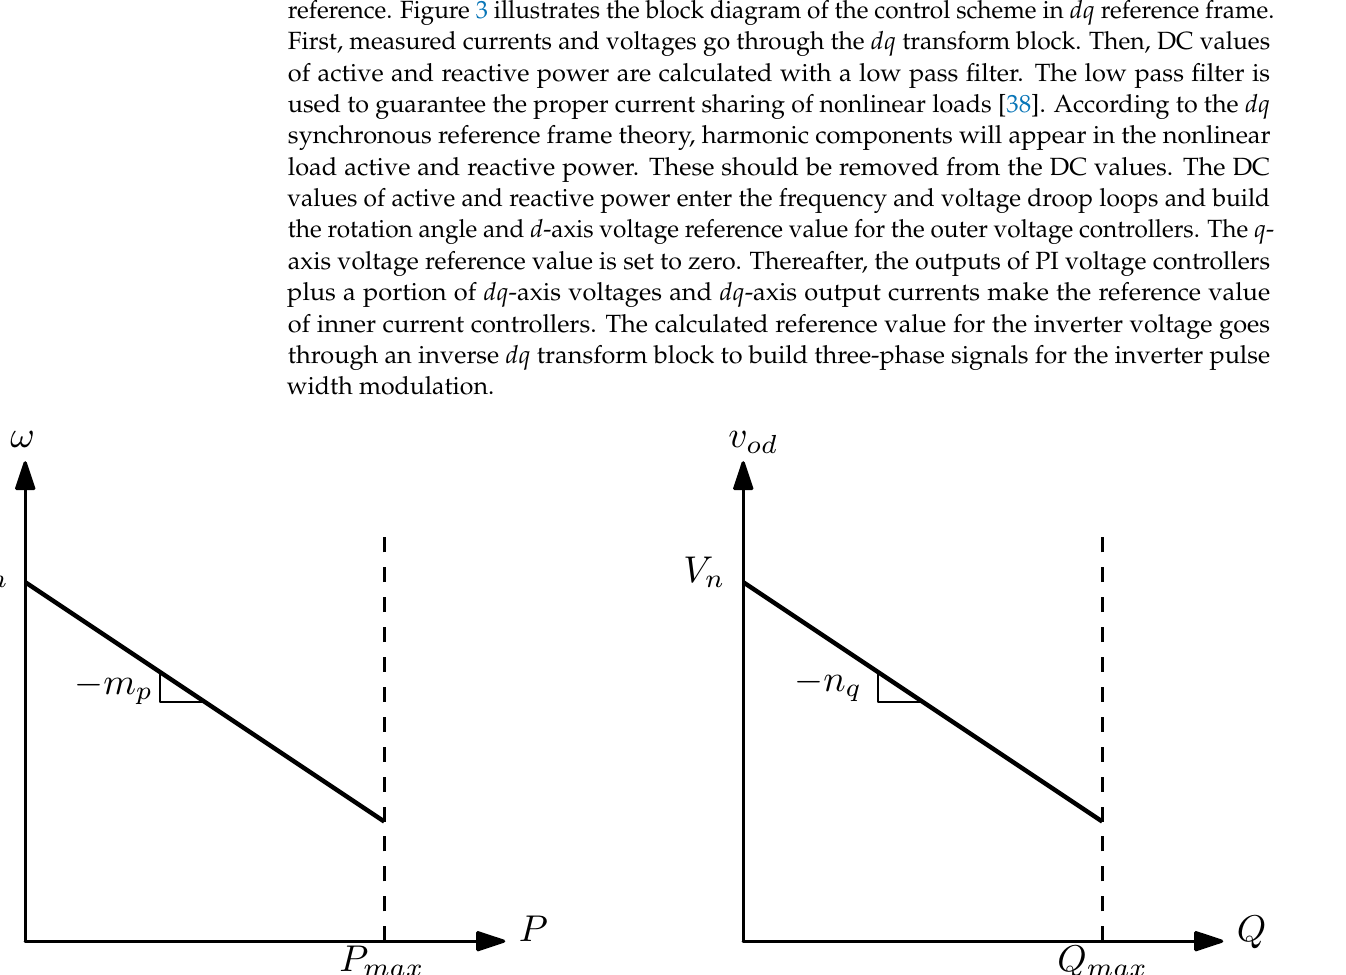
Figure 2. Artificial linear characteristics with the slope of − m p for the inverter frequency and the slope of − n q for the inverter